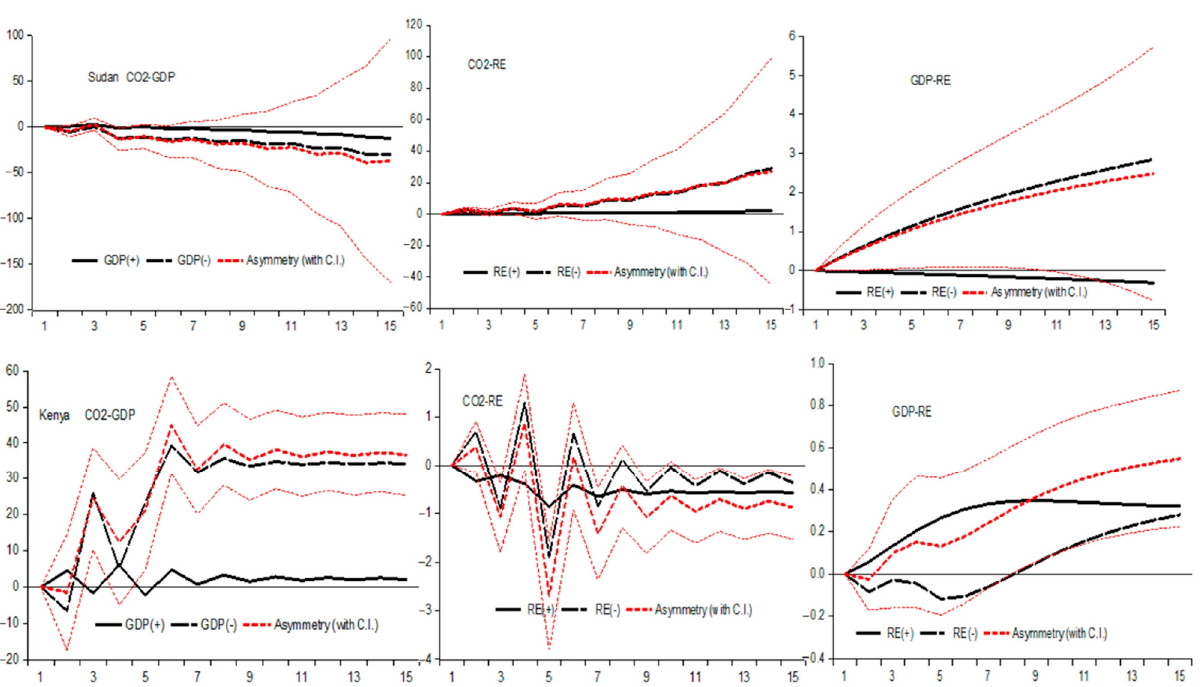
Energies 2021 , 14 , x FOR PEER REVIEW Figure 1. Dynamic multiplier plots of the nonlinear asymmetric and symmetric relationships between CO 2 emissions and GDP, CO 2 emissions and renewable energy, and GDP and renewable energy in Sudan and Kenya.